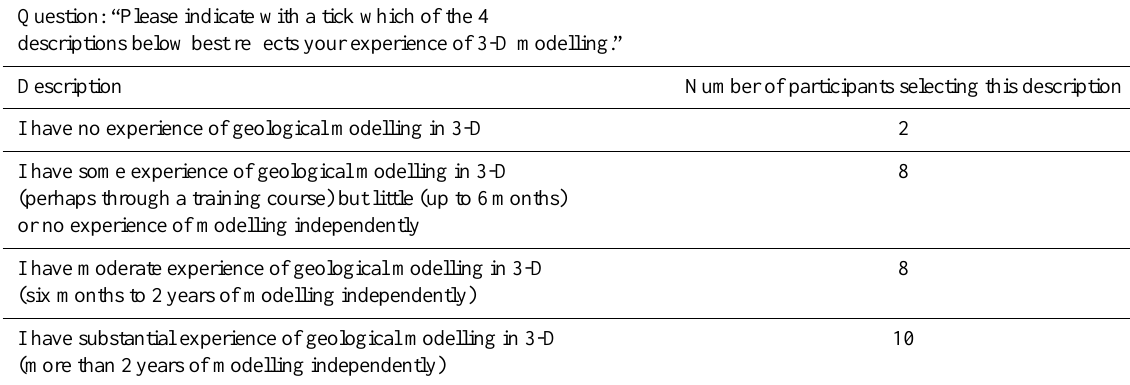
Table 1. Questionnaire on modelling experience and responses received. Question: “Please indicate with a tick which of the